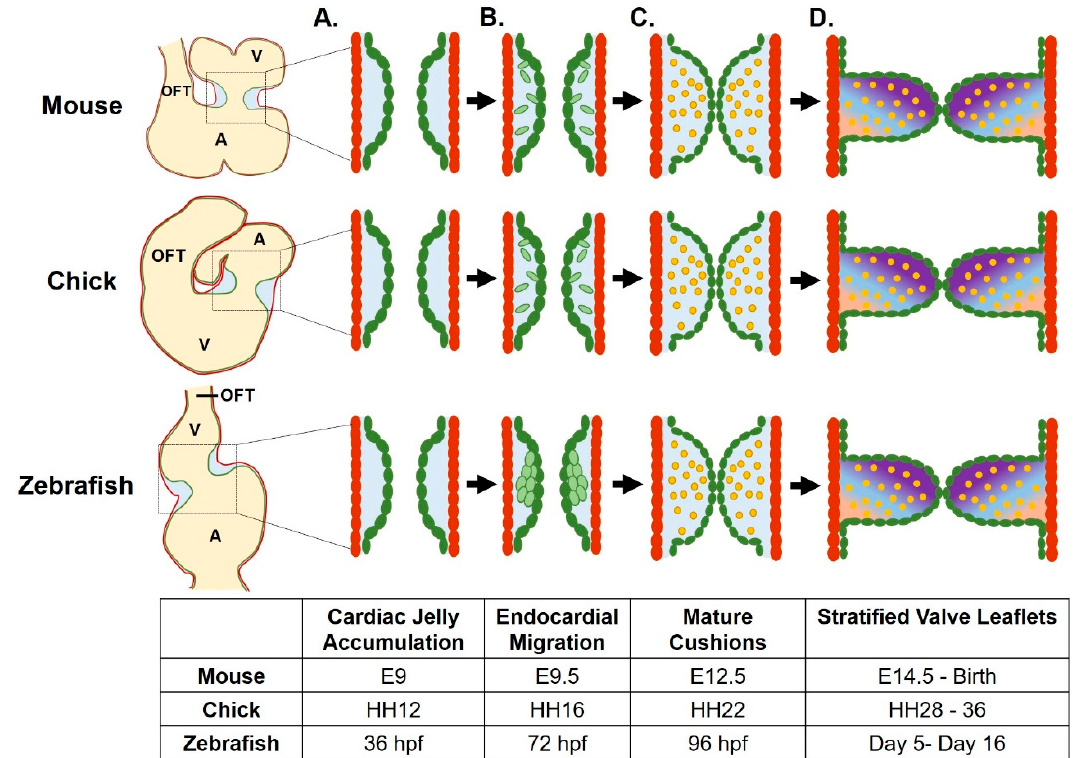
Figure 1. Atrioventricular valve development across species. ( A ) Valve development begins as cardiac jelly accumulates between the myocardial (red) and endocardial cell layers. ( B ) Endocardial cushions (ECs, in green) are created as endocardial cells invade the cardiac jelly following epithelial to mesenchymal transition (mouse, chick) or via a local invagination of the endocardium (zebrafish). ( C ) ECs mature as the mesenchymal cells differentiate into valve interstitial cells (VICs, in yellow) as the cushions begin to function to occlude retrograde flow. ( D ) Valve leaflets form from remodeled ECs, as VICs proliferate, stratify, and differentially modify the extracellular matrix (ECM). Gradient represents three layers of stratified ECM. A, atrium; V, ventricle; OFT, outflow tract. Figure created using BioRender.